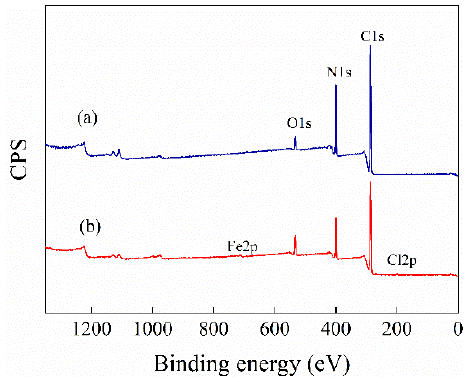
Figure 4. FTIR spectra of n-PAN and n-hemin/PAN.